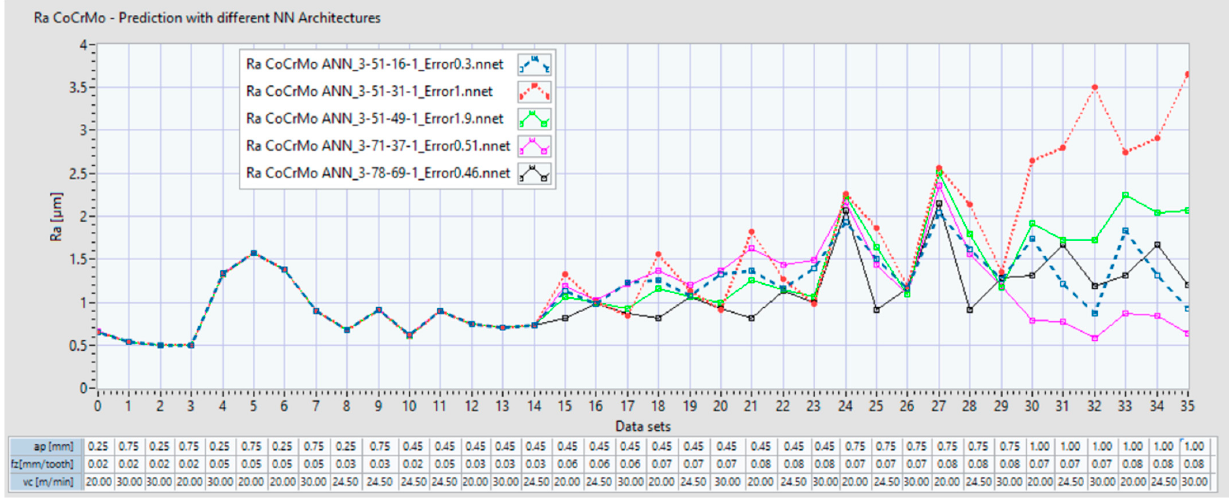
Figure 17. Prediction of Ra with 5 ANNs for Co–28Cr–6Mo with a data set of 36 inputs.